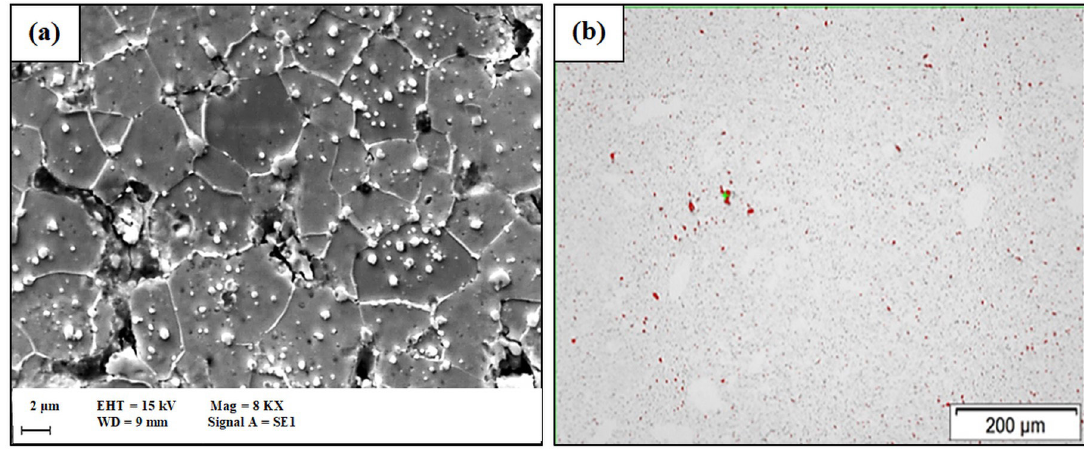
Figure 3. Microstructure of X22CrMoV12-1 alloy with VC addition after sintering (a) SEM analysis (b) OM analysis of apparent